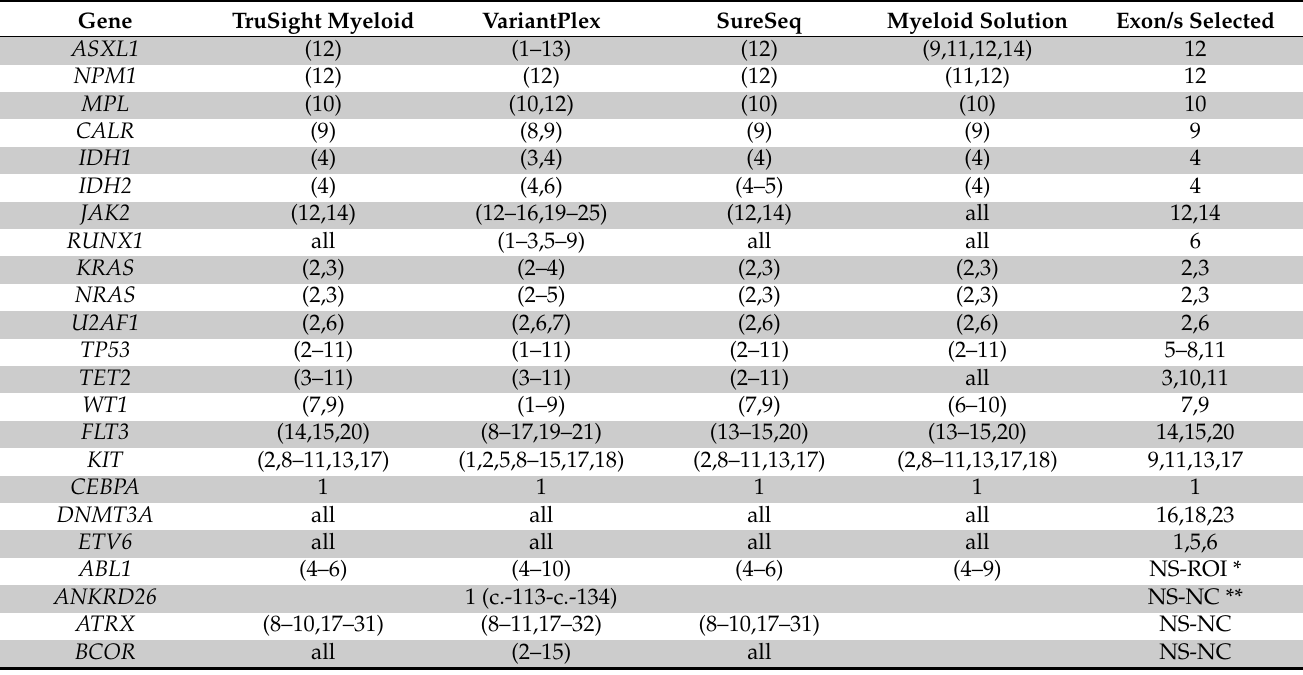
Table 1. Genes/Exons covered by